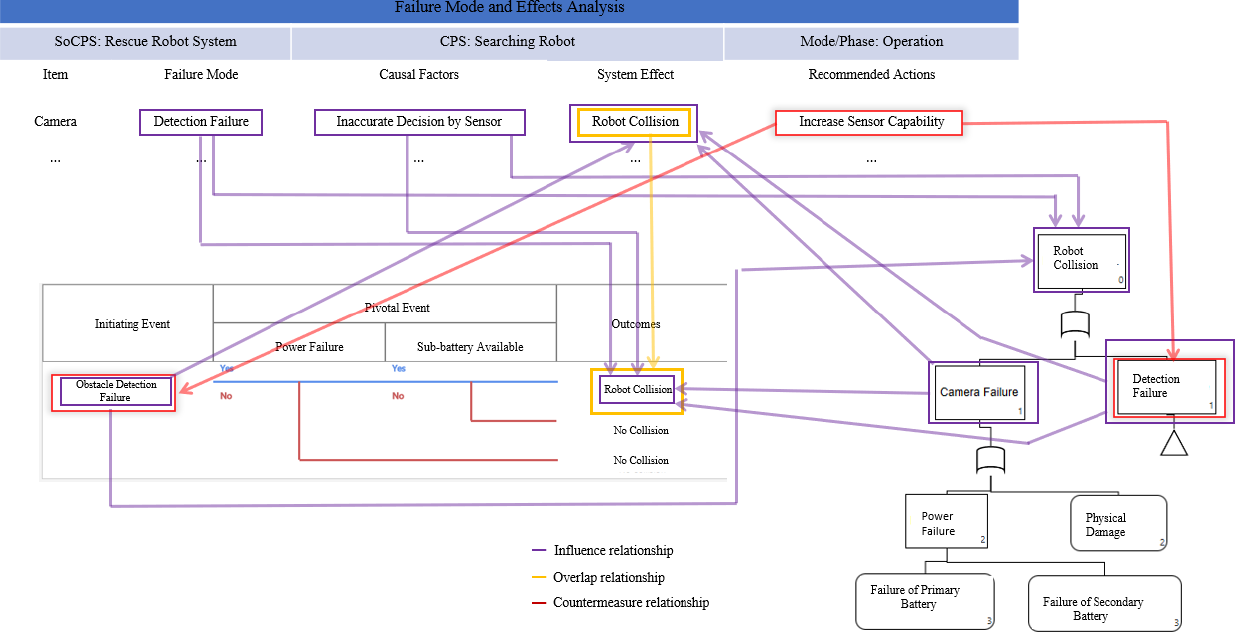
Figure 1. Example of relationships among hazard analysis artifacts (FMEA, FTA and ETA) .